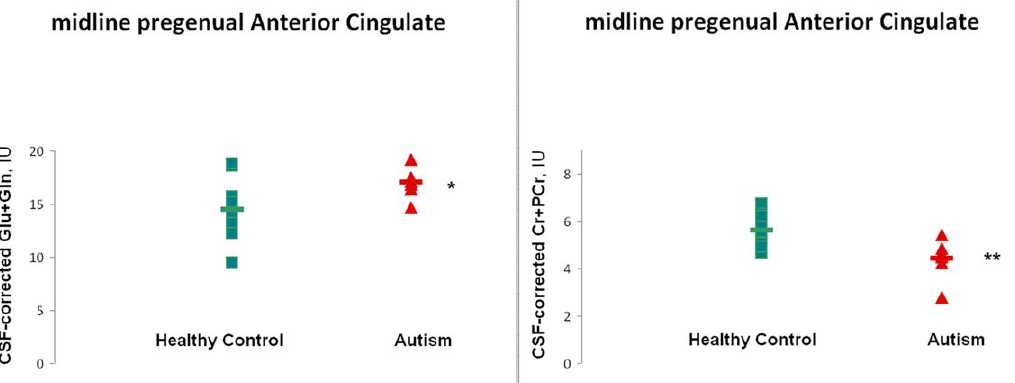
Figure 3. LCModel-derived absolute metabolite levels in Institutional Units ( IU ) corrected for voxel CSF-content for subjects with ASD ( redtriangles ) and healthy controls ( greensquares ) . Horizontal bars denote group means. Values are shown for glutamate + glutamine (‘‘Glx’’; left ) and creatine + phosphocreatine ( right ) in pACC. Note elevated Glx and deptressed Cr + PCr in subjects with ASD . * p , .05, ** p , .01 (independent T-test following ANCOVA of rank-transformed, therefore non-parametric data.) Experiment 1.